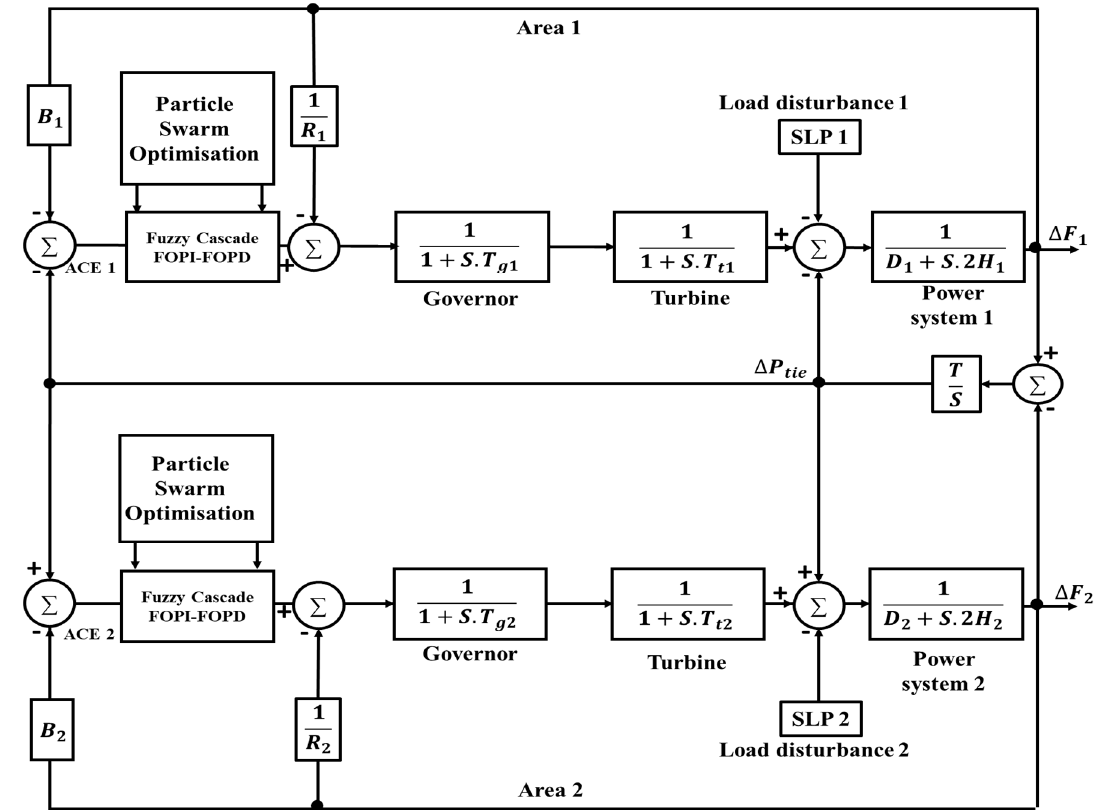
Figure 1. The block diagram of the two-area power